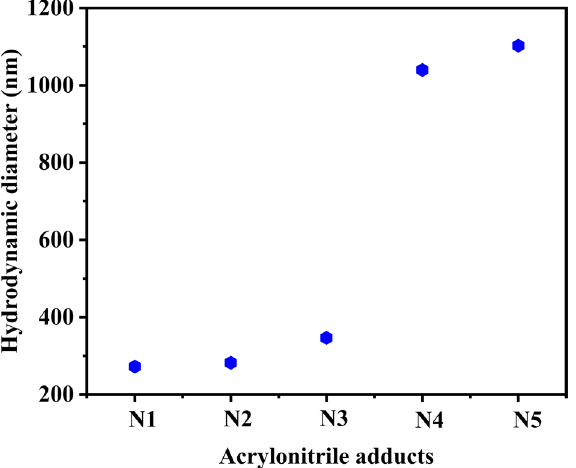
Figure 3. Hydrodynamic diameter of (i) n-propyliminobis-propionitrile (N1) , (ii) n-butyliminobis- propionitrile (N2) , (iii) n-hexyliminopropionitrile (N3) , (iv) n-decyliminopropionitrile (N4) and (v) n-dodecyliminopropionitrile (N5)